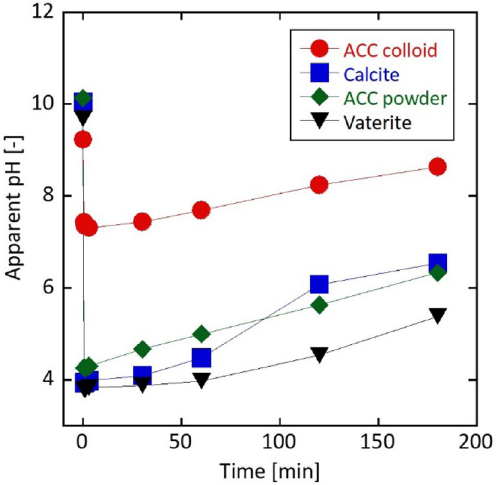
Figure 7. Time dependence of the apparent pH during the phosphorylation reaction conducted in a water system using ACC colloid, powdered ACC, vaterite, and calcite suspensions. Particle concentration is 1 wt%, and the molar ratio of Ca/P is